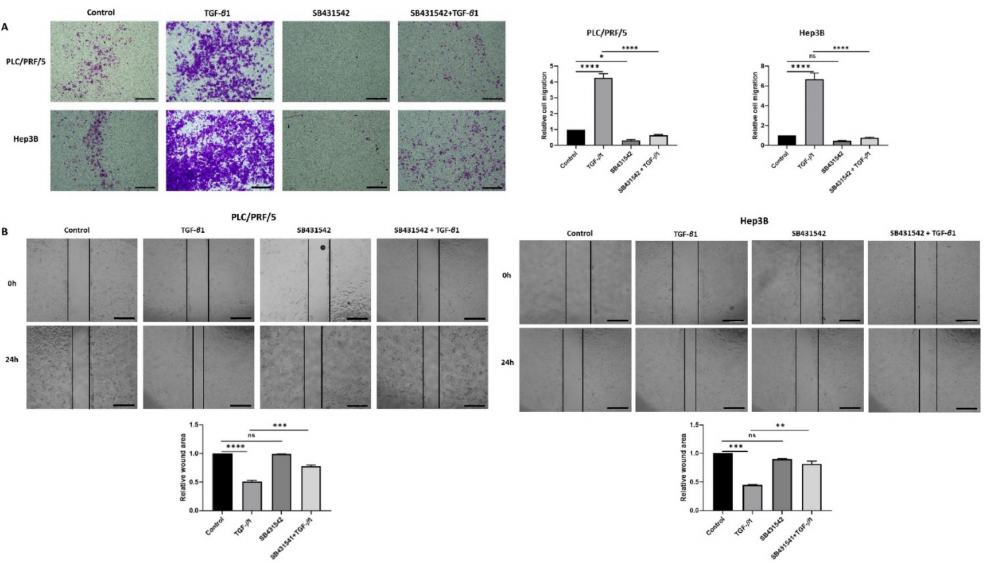
Figure 4. SB431542 reverses migratory capability of TGF- β 1-stimulated HCC cells. ( A ) Transwell migration assay revealed reduced migratory capability of PLC/PRF/5 and Hep3B cell lines upon treatment with SB431542 despite stimulation with TGF- β 1 (scale bar = 500 µ m). Quantitative analysis of motile cells was determined by measuring the absorbance of Crystal Violet staining. ( B ) Wound healing assay confirmed decreased motility of PLC/PRF/5 and Hep3B cells upon treatment with SB431542 despite stimulation with TGF- β 1 (scale bar = 500 µ m). Wound area was analysed with TGF- β 1, SB431542, or combination treatment for 24 h relative to the starting wound area at 0 h ( n = 3, * p < 0.05, ** p < 0.01, *** p < 0.005, **** p <